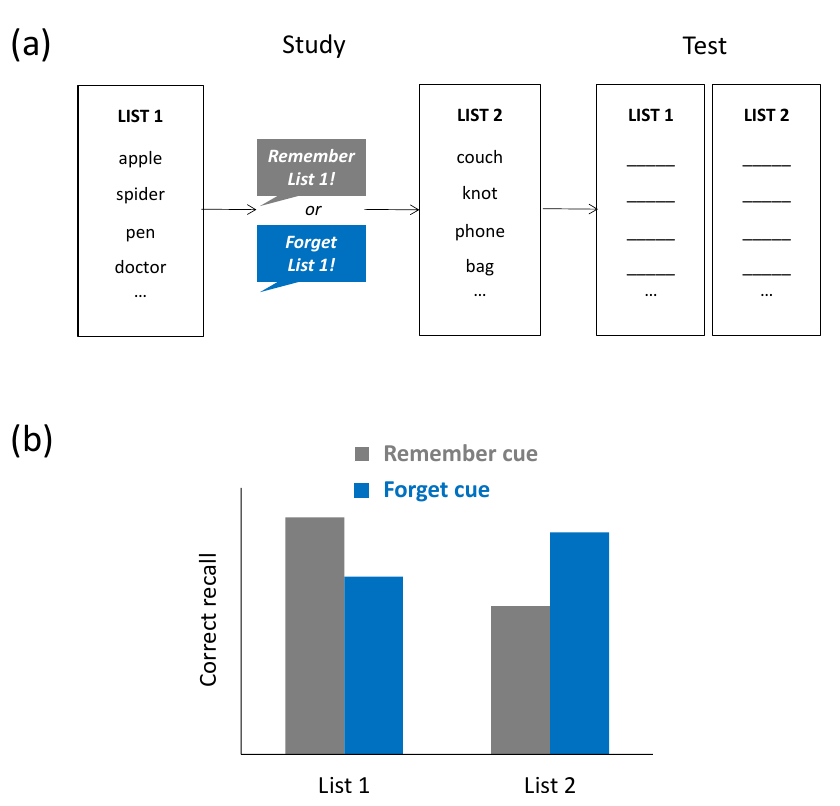
Figure 3. List-method directed forgetting task. ( a ) Typical task: Participants study two lists of items and, after study of list 1, they are asked to keep remembering the list for a later retention test or to forget the list altogether. After study of list 2—which is always to-be-remembered—subjects’ memory of both study lists is assessed, irrespective of original cuing. ( b ) Typical results: Compared to subjects who were cued to remember list 1, subjects who were were cued to forget list 1 show impaired recall of list 1 and enhanced recall of list